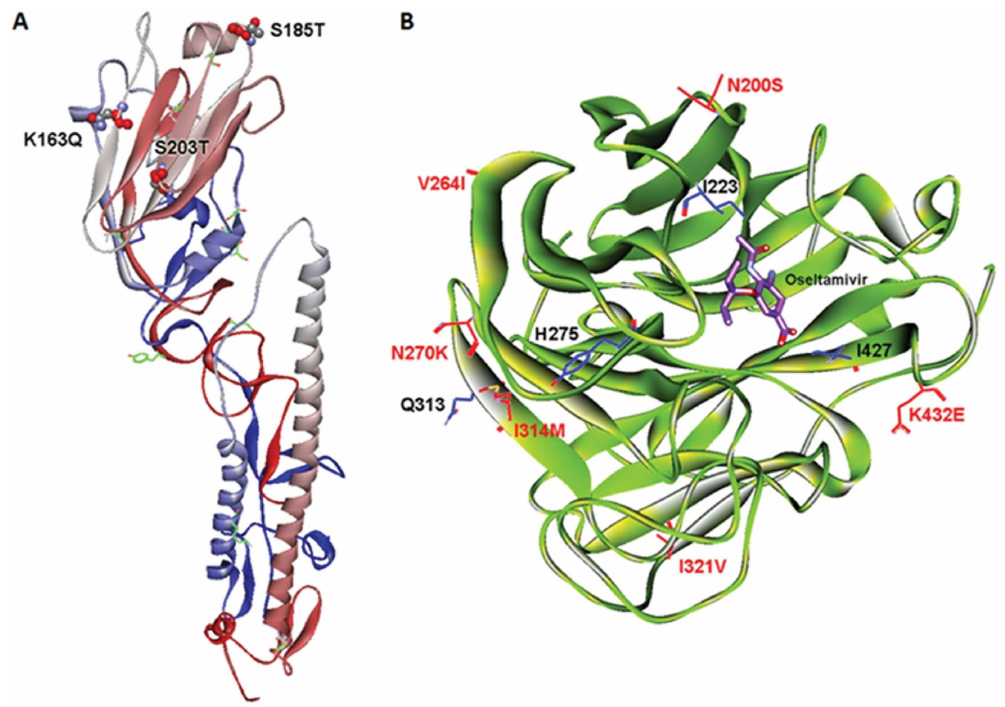
Fig 4. Three-dimensional quaternary structure of HA (A) and NA (B) proteins of 2015 A(H1N1)pdm09 strains from this study identifying mutations compared to A/California/04/2009 strain. The three mutations at the antigenicepitopes within the receptor-bindingpocket of HA protein were indicated.Probablebindingpositionof oseltamivirin the NA protein of 2015 A(H1N1)pdm09 strain is shown in purplecolour. The mutations are indicatedin red and the amino acids responsible for oseltamivirbindingare shown in